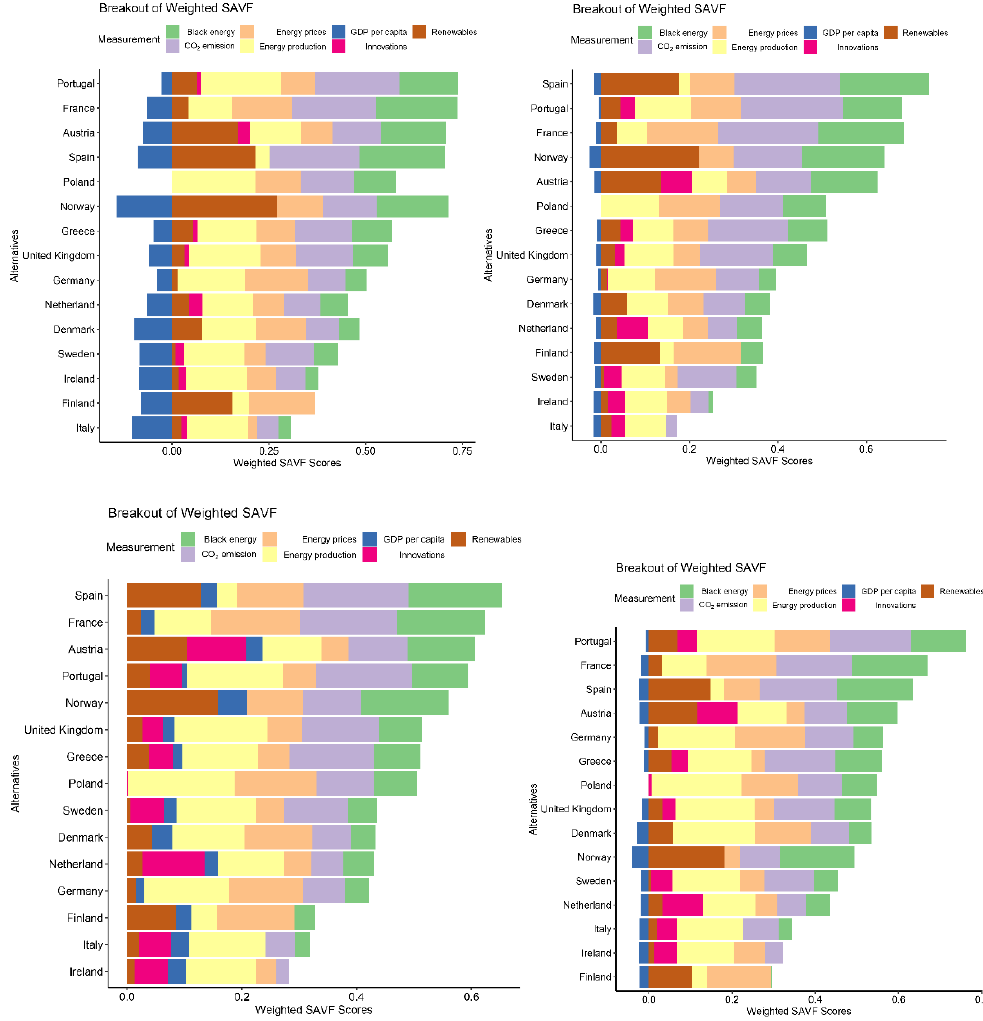
Figure 10 Influence of used variables on the overall SISED for all EU countries in 2007–2010.